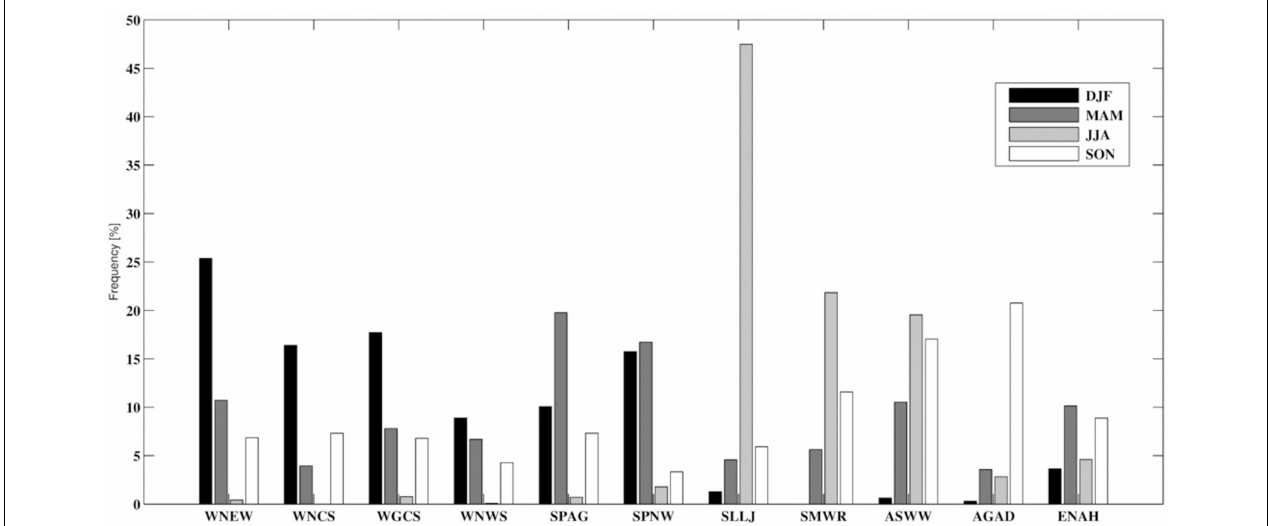
FIGURE 2 | Relative seasonal frequencies showing the dominance of the 11 regimes found. For each season all regime frequencies should sum up to a 100%.